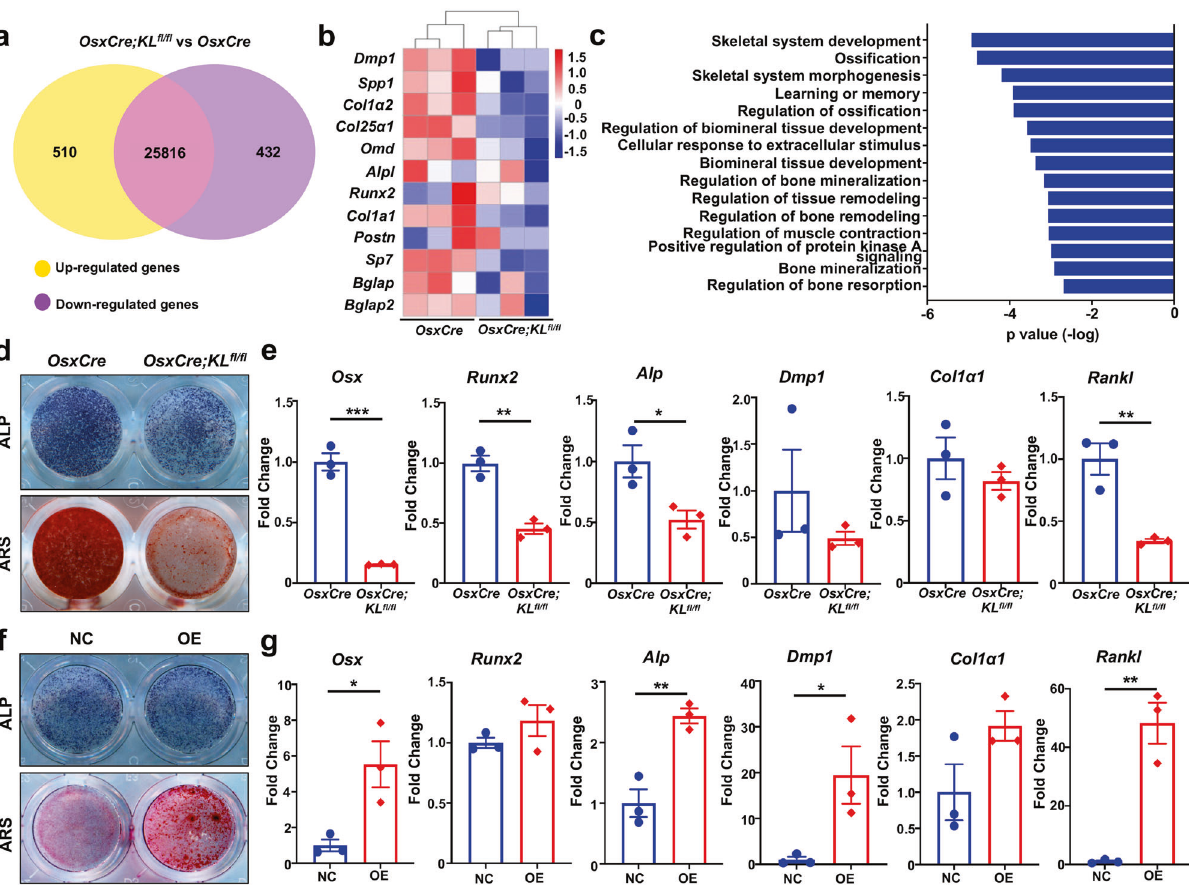
Fig. 2 Klotho favors skeletal system development by promoting osteogenic differentiation. a Venn diagram showing 510 genes uniquely upregulated while 432 genes downregulated in Klotho-ablated mandibles ( p -value < 0.05). n = 3. b Heatmap of representative genes associated with osteogenesis. Red indicates upregulated expression; blue indicates downregulated expression. c Gene ontology (GO) enrichment analysis of downregulated genes in total differentially expressed genes (DEGs). d Alkaline phosphatase (ALP) staining and alizarin red staining (ARS), respectively, at 7 days (7d) and 14 days of osteogenic induction in primary calvarial osteoblasts from OsxCre and OsxCre;KL fl / fl mice. n = 3. e Transcription of Osx, Runx2, Alp, Dmp1, Col1 α 1 , and Rankl after 14d induction. n = 3. f ALP staining and ARS after transfected lentivirus particles to overexpress Klotho (OE) or empty load (NC). n = 3. g Transcription of genes after 14 days of induction. n = 3. * p < 0.05, ** p < 0.01, *** p < 0.001. All data are shown as the mean ±